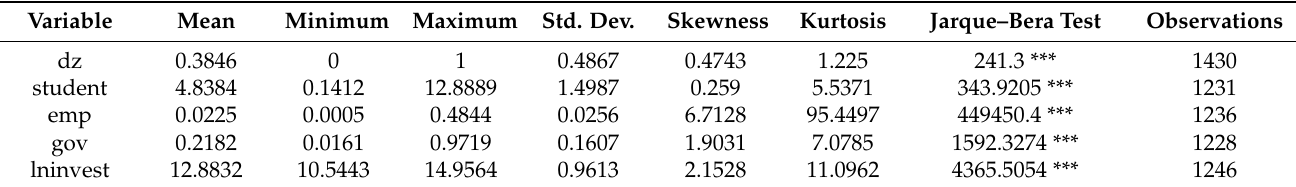
Table 2. Descriptive statistics of independent